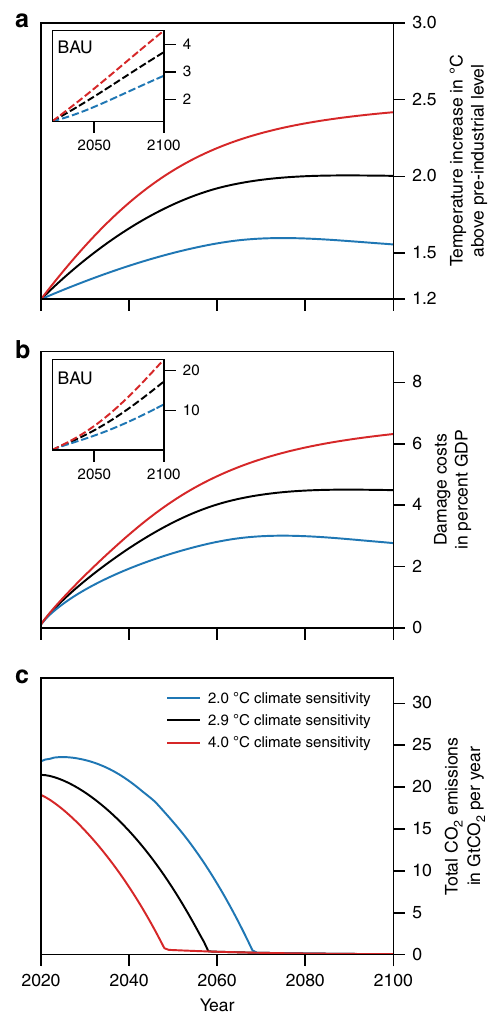
Fig. 2 Temperature increase, damage costs, and carbon emissions under cost-bene fi t optimal policy for three different climate sensitivities. The black curves are associated with the original calibration of the climate sensitivity of 2.9°C; the blue curves with a 2°C climate sensitivity and the red curve with a 4°C climate sensitivity. The inset fi gures allow comparing the economically optimal temperature development and damage costs with their corresponding values in the